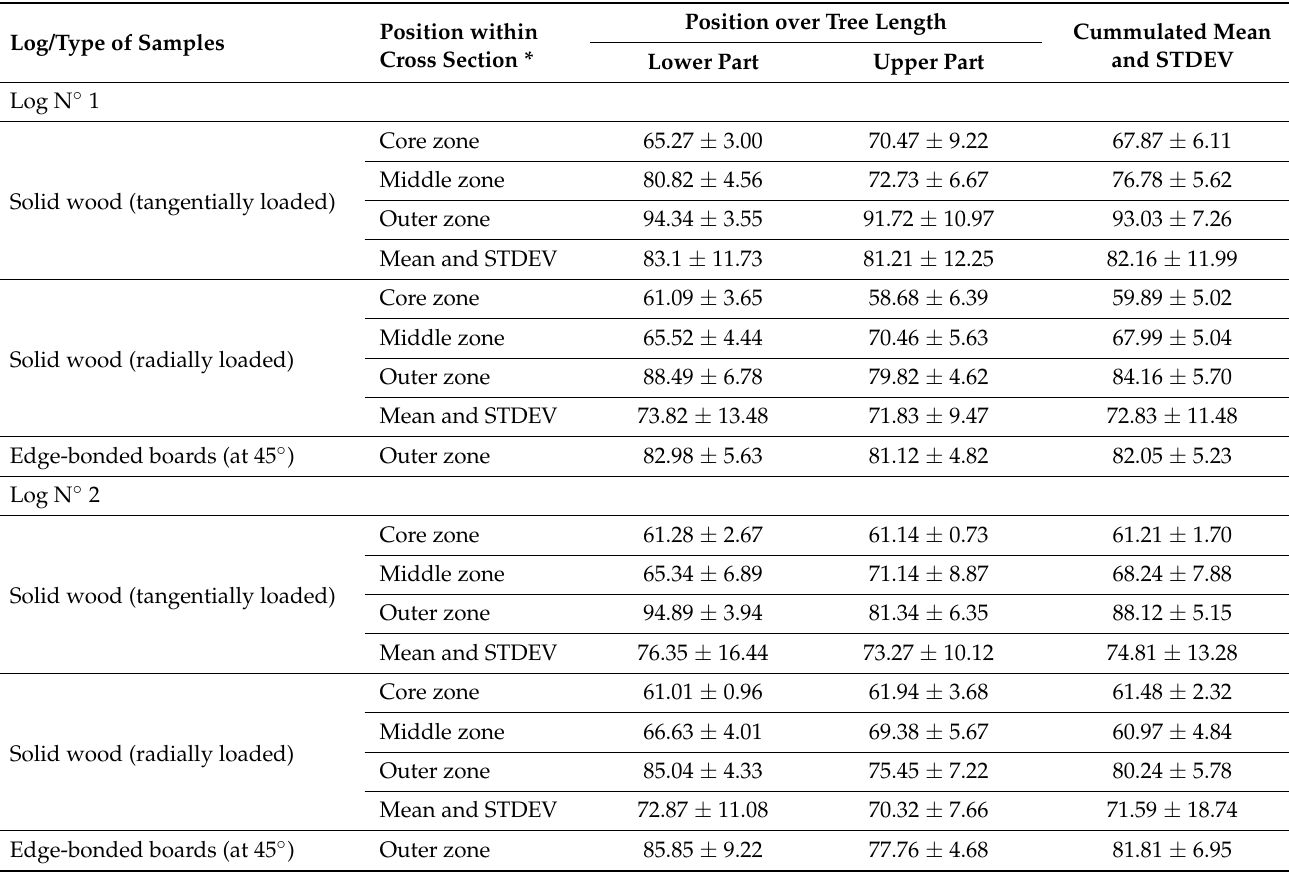
Table 5. Bending strength MOR 12 (in N/mm 2 ) of solid and glued spruce